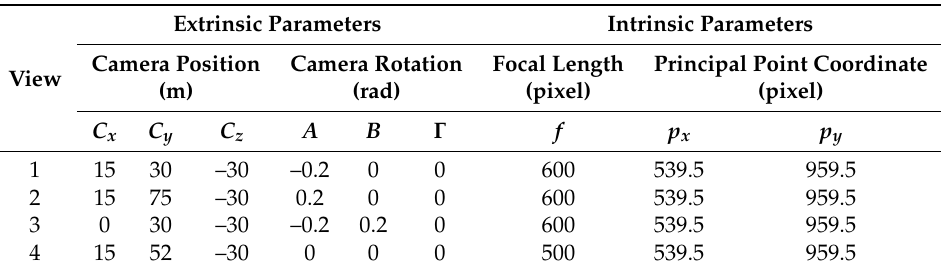
Table 3. Camera parameters of each